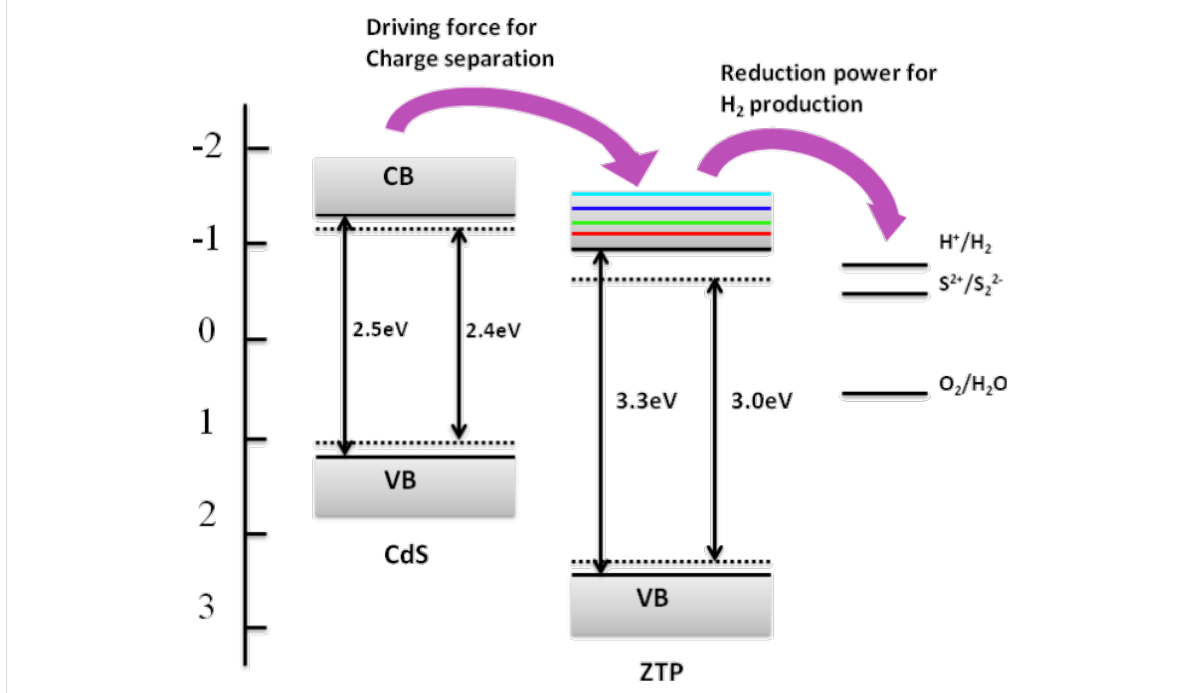
Figure 8: Schematic illustration for the charge separation in CdS/mesoporous ZTP. Reprinted with permission from [60]. Copyright (2007) The American Chemical Society.